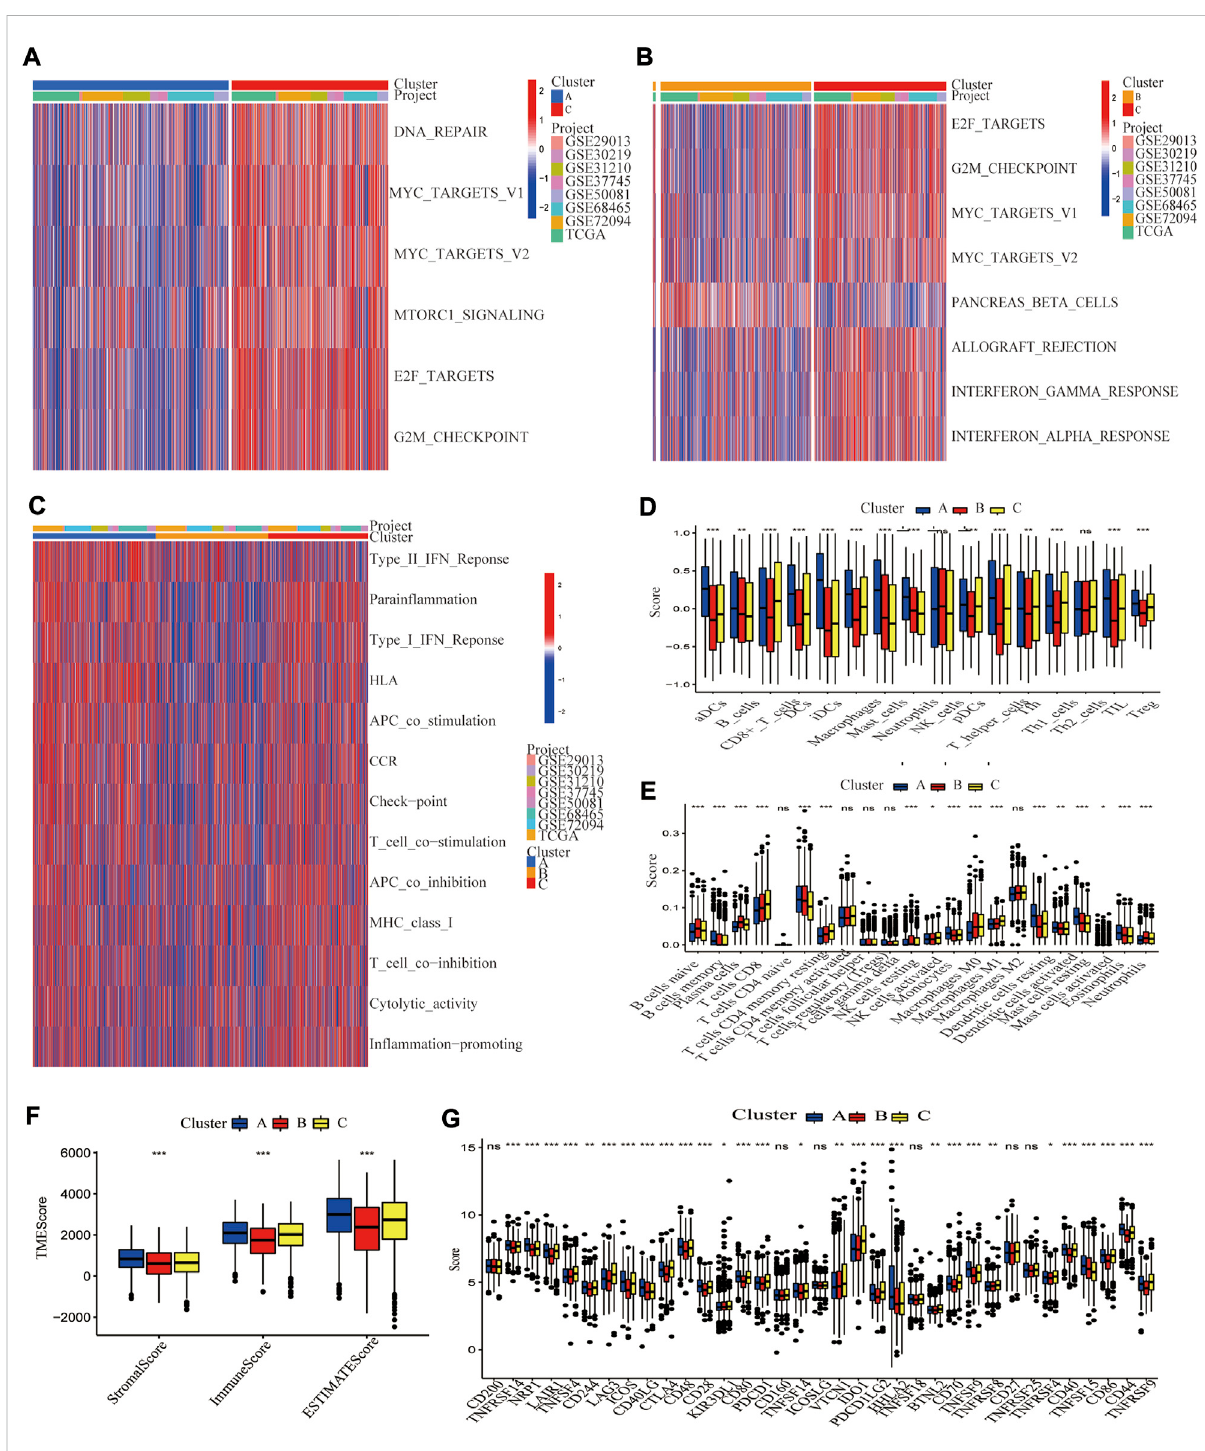
FIGURE 4 Differences in biological pathways and tumor microenvironment among three cuproptosis molecular subtypes of LUAD. GSVA analyzed the biological pathways of three cuproptosis subtypes. Red represents activation of biological pathways, and blue represents inhibition of biological pathways. (A) Cluster A vs. Cluster C; (B) Cluster B vs. Cluster C. (C) The immune-related pathway differences in Clusters A – C. Two algorithms demonstrated the abundance of TME cell in fi ltration for three cuproptosis subtypes (D) by ssGSEA; (E) by CEBERSORT. Statistical differences between the three clusters were analyzed by a one-way ANOVA test. (F) Tumor microenvironment scores between the three cuproptosis subtypes, including Stromal score, Immune score, and Estimated score. (G) Differential expression of different immune checkpoint genes among the three cuproptosis subtypes.*, **, and ***, represent p < 0.05, p < 0.01, and p < 0.001,